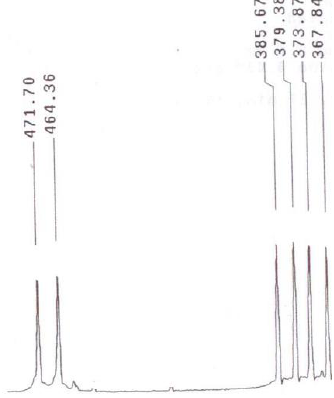
Figure 3. A stereoview of the repeating supramolecular motif in the crystal of 2 propagating parallel to the crystal c-axis ( a ), and the crystal packing shown in the [010] projection ( b ). Dotted lines represent hydrogen bonds.